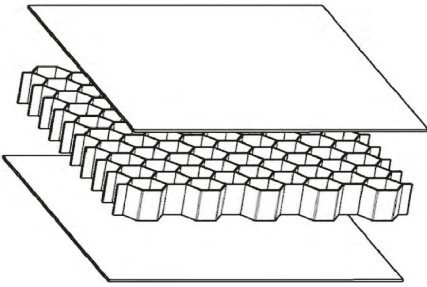
Figure 6: Honeycomb sandwich